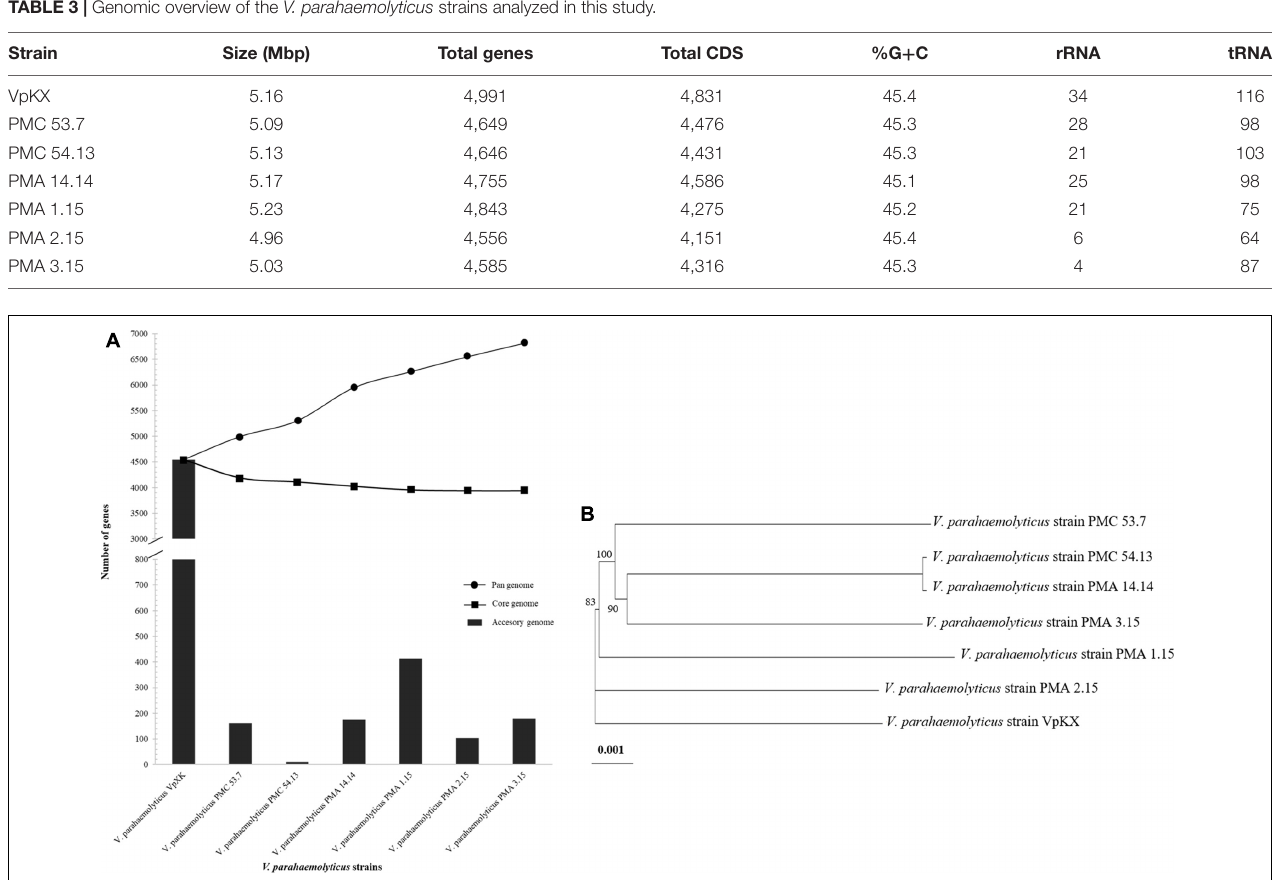
TABLE 3 | Genomic overview of the V. parahaemolyticus strains analyzed in this study.